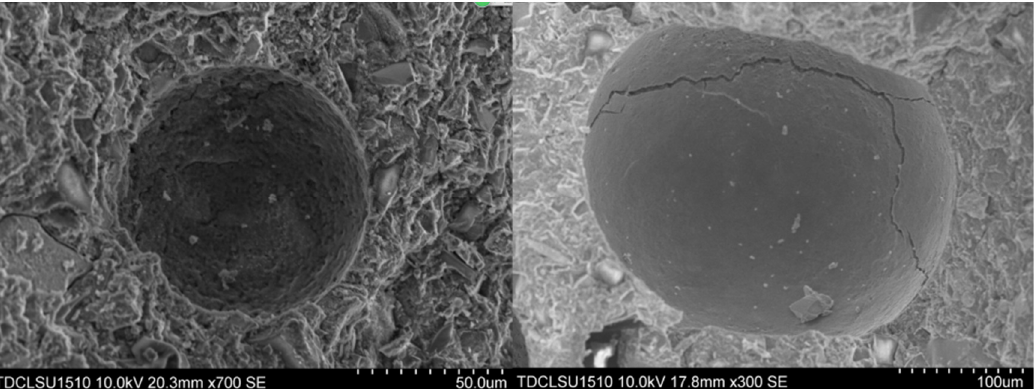
Figure 3. Superabsorbent polymer (SAP) particles and formed pores (SEM).